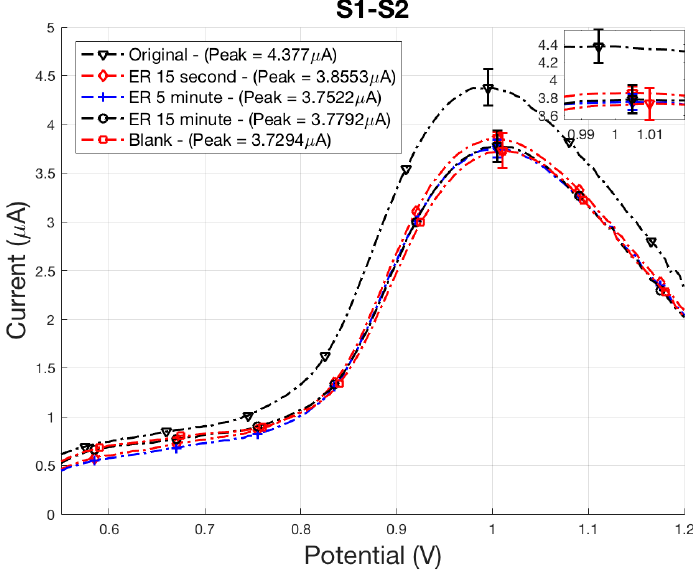
Figure 6. ER-treated E. coli electrochemical SWV curves displaying the oxidation of polyG tag.